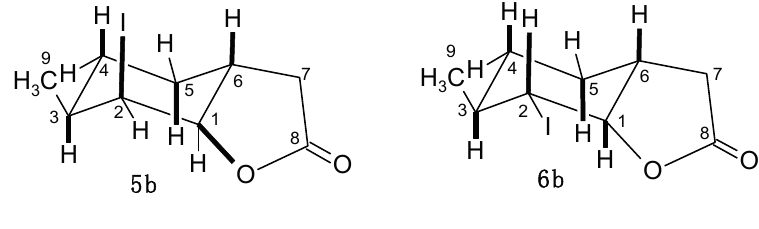
Figure 4. Structure of iodolactones 5b and 6b